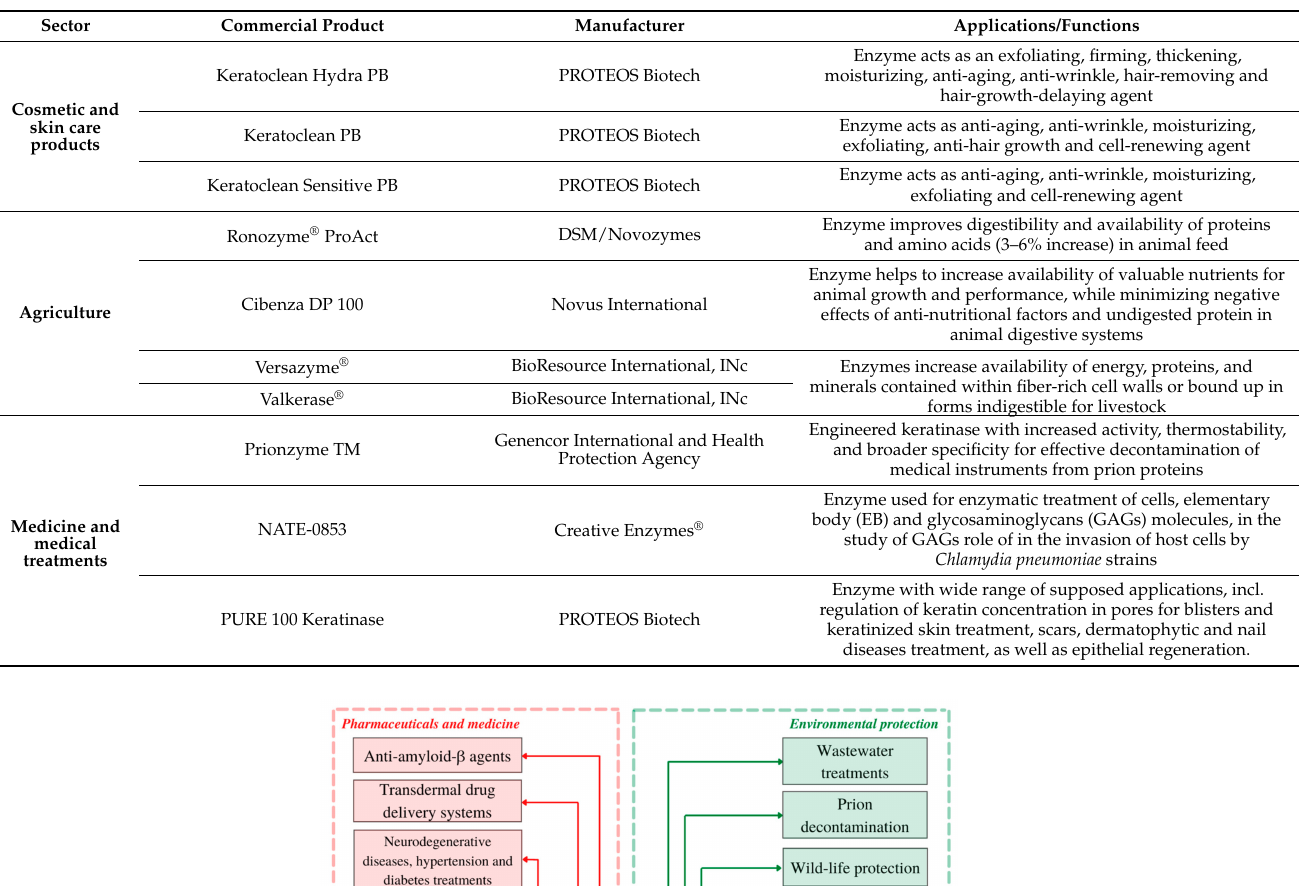
Table 6. Commercial biotechnological applications of keratinases [17,19,39,132].